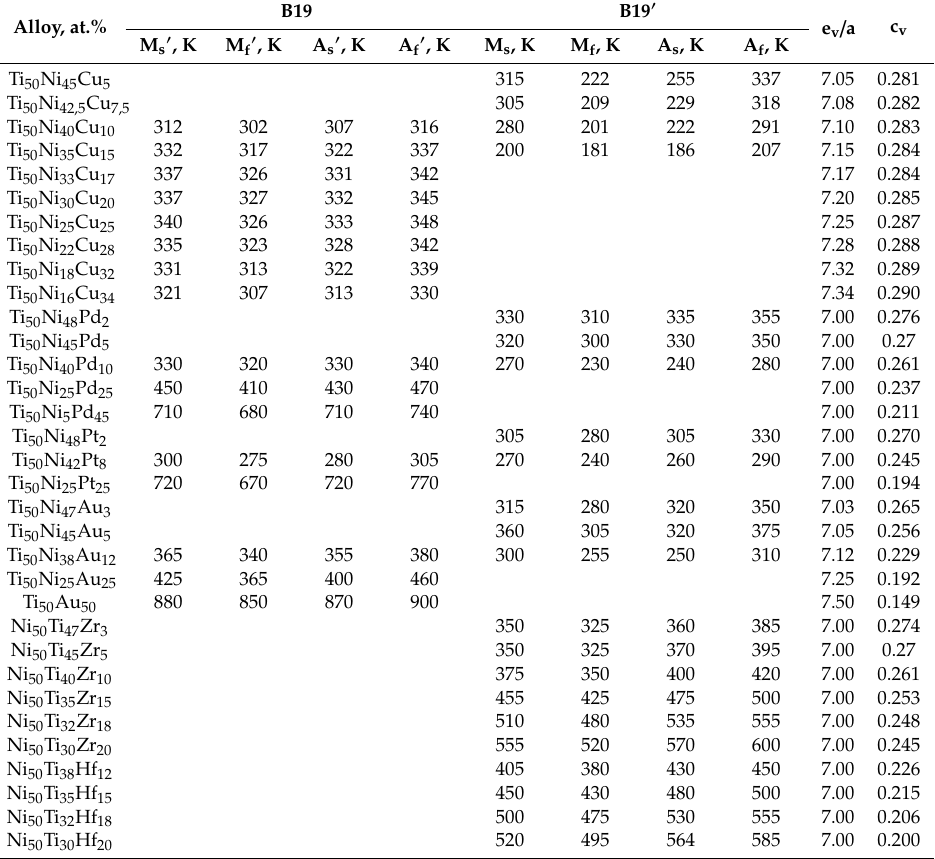
Table 2. Chemical composition, temperatures of TMTs B2 ↔ B19 ↔ B19 (cid:48) , number of valence electrons per atom e v / a and their concentration c v